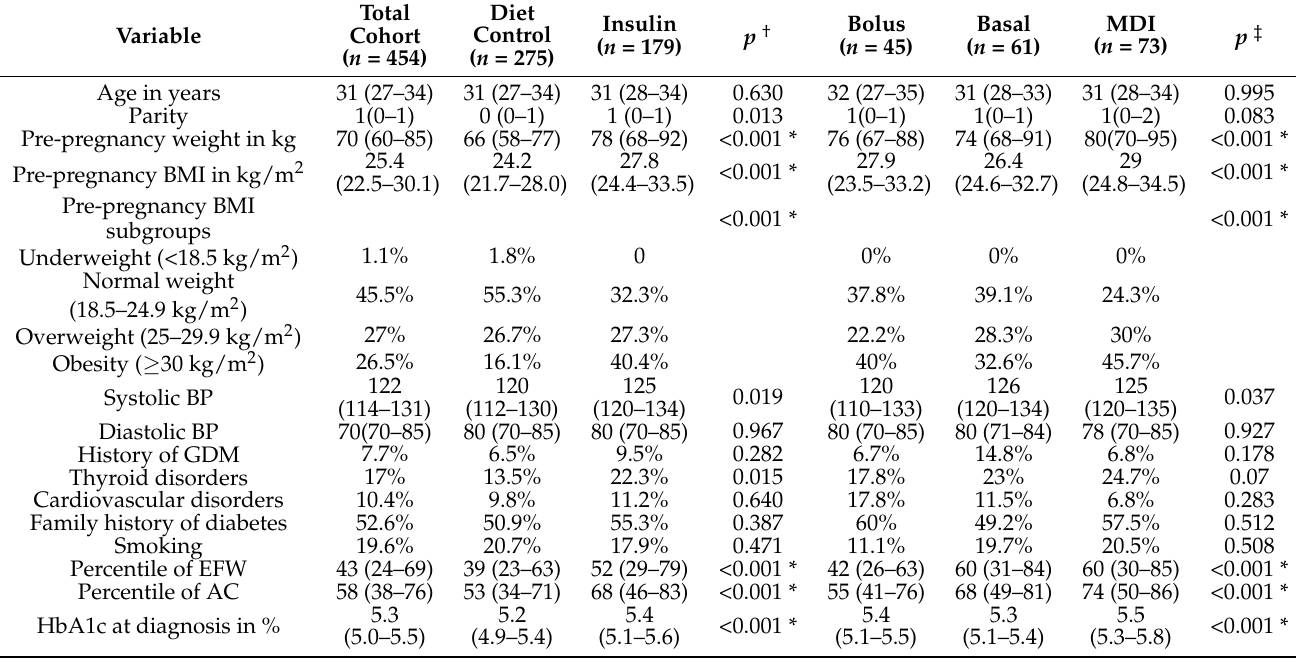
Table 1. Predictive parameters for treatment groups based on